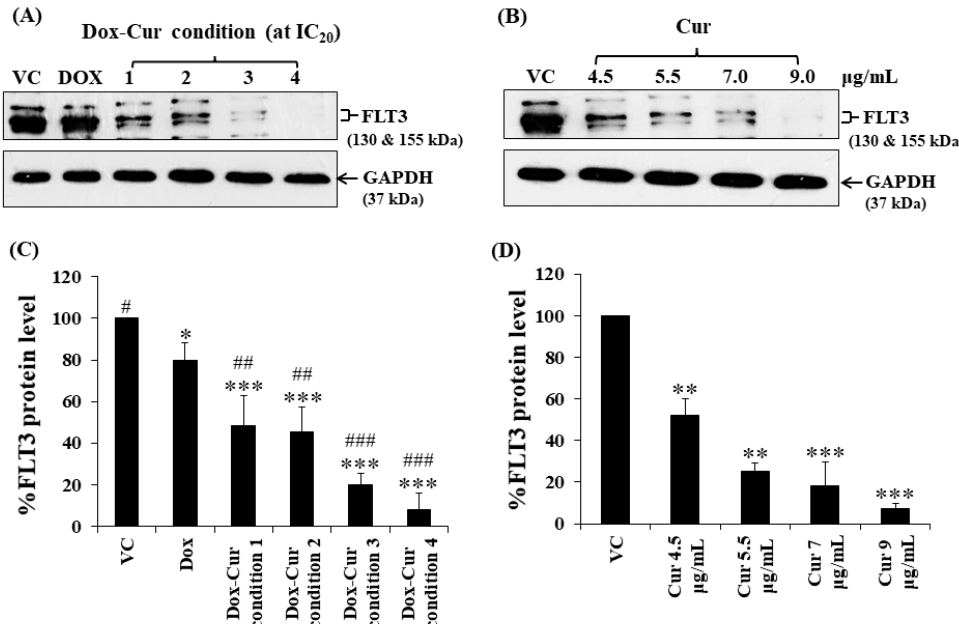
Figure 2. FLT3 protein expression of KG-1a cells after treatment with Dox and combined treatment of Dox–Cur at concentration value of IC 20 for 48 h. Protein bands ( A ) and percentage ( C ) of FLT3 protein expression level of KG-1a cells treated with DMSO (VC), Dox at concentration of 60 ng/mL, Dox–Cur condition 1 (15 ng/mL Dox + 4.5 µ g/mL Cur), Dox–Cur condition 2 (16 ng/mL Dox + 5.5 µ g/mL Cur), Dox–Cur condition 3 (12 ng/mL Dox + 7 µ g/mL Cur), and Dox–Cur condition 4 (8 ng/mL Dox + 9 µ g/mL Cur) for 48 h. Whole protein lysates (80 µ g/lane) were loaded onto SDS-PAGE. Protein bands ( B ) and percentage ( D ) of FLT3 protein expression level of KG-1a cells treated with DMSO (VC), Cur (4.5 μ g/mL), Cur (5.5 μ g/mL), Cur (7 μ g/mL), and Cur (9 μ g/mL) for 48 h. The data are shown as mean ± SD from 3 independent experiments. The significance of mean differences was assessed using one-way ANOVA. * p < 0.05, ** p < 0.01, and *** p < 0.001 compared with VC. # p < 0.05, ## p < 0.01, and ### p < 0.001 compared with single-Dox treatment.